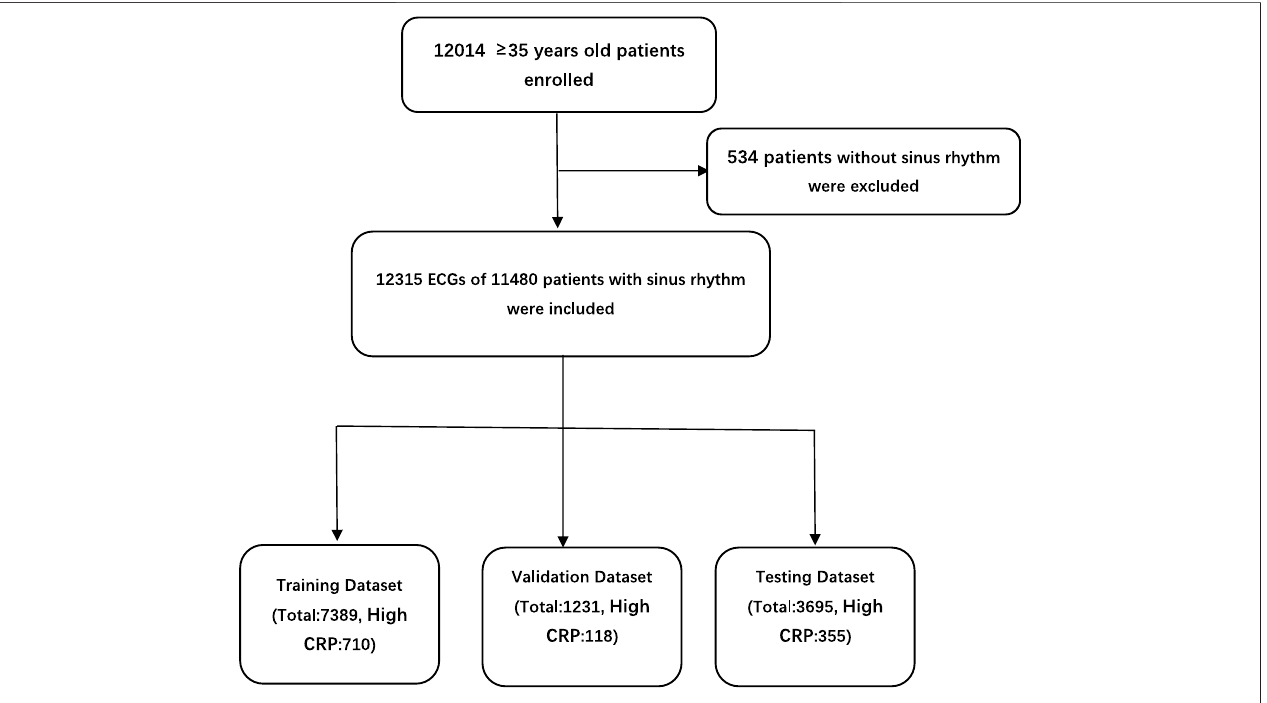
FIGURE 1 | Patient fl ow